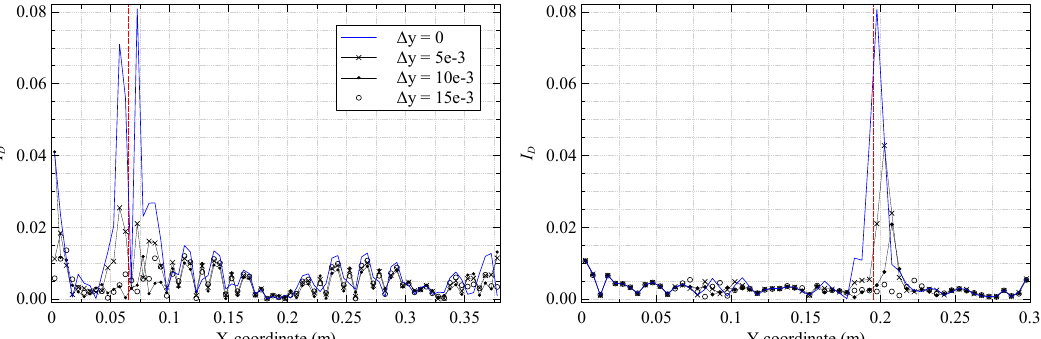
Figure 13. Damage index plots along ( left ) y = 197.5 mm and ( right ) x = 72.5 mm for different fiber locations.